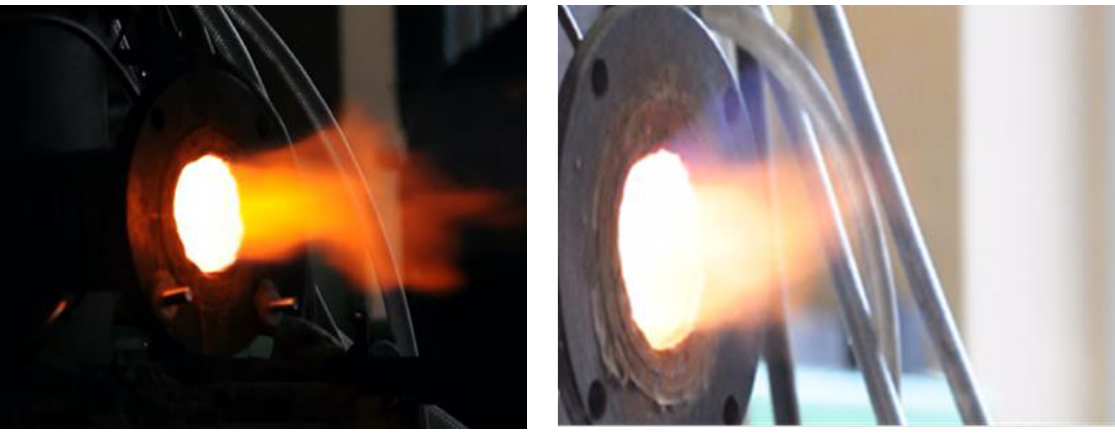
Figure 7. View of the reactor exhaust gas glow.